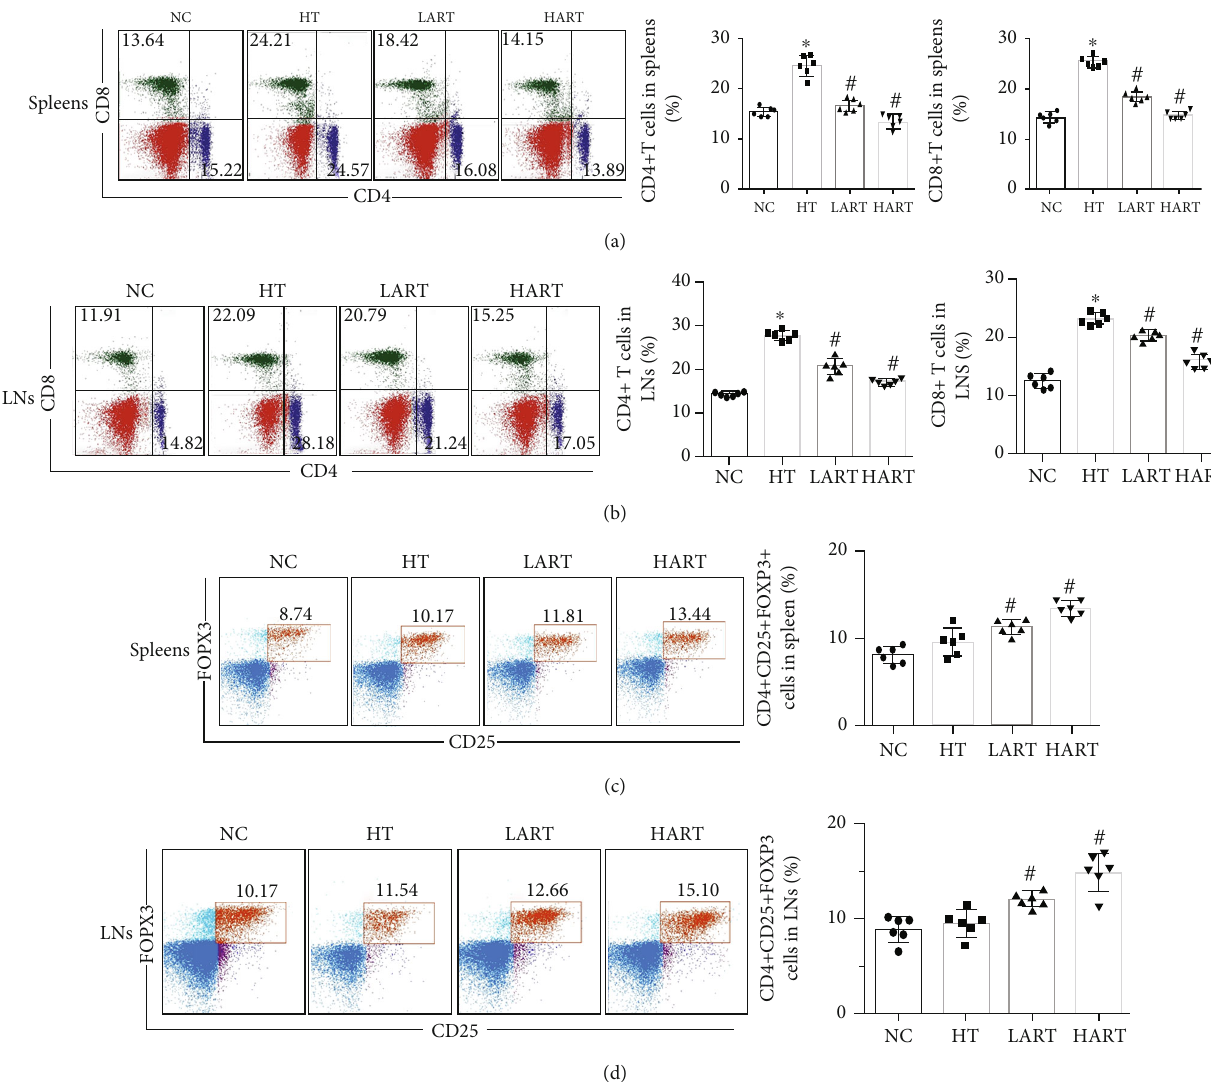
Figure 3: (a) Flow cytometric sorting of CD4+/8+ T cells in spleens and statistics chart; (b) fl ow cytometric sorting of CD4+/8+ T cells in LNs and statistics chart; (c) CD4+CD25+FOXP3+ cells in spleens and statistics chart; (d) CD4+CD25+FOXP3+ cells in LNs and statistics chart ( ∗ P < 0 : 05 compared with NC; # P < 0 : 05 compared with